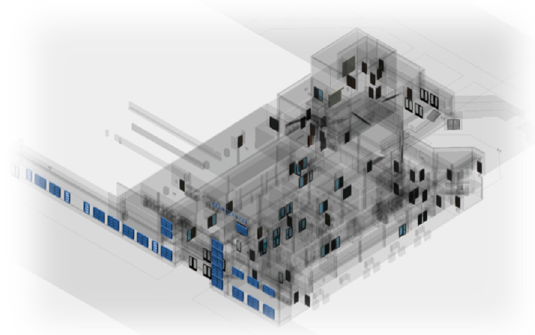
Figure 1. The Building Information Model: The required macro-features (doors and windows) are extracted and highlighted. Doors are depicted in black and windows in blue. All the other components are represented in translucent gray.